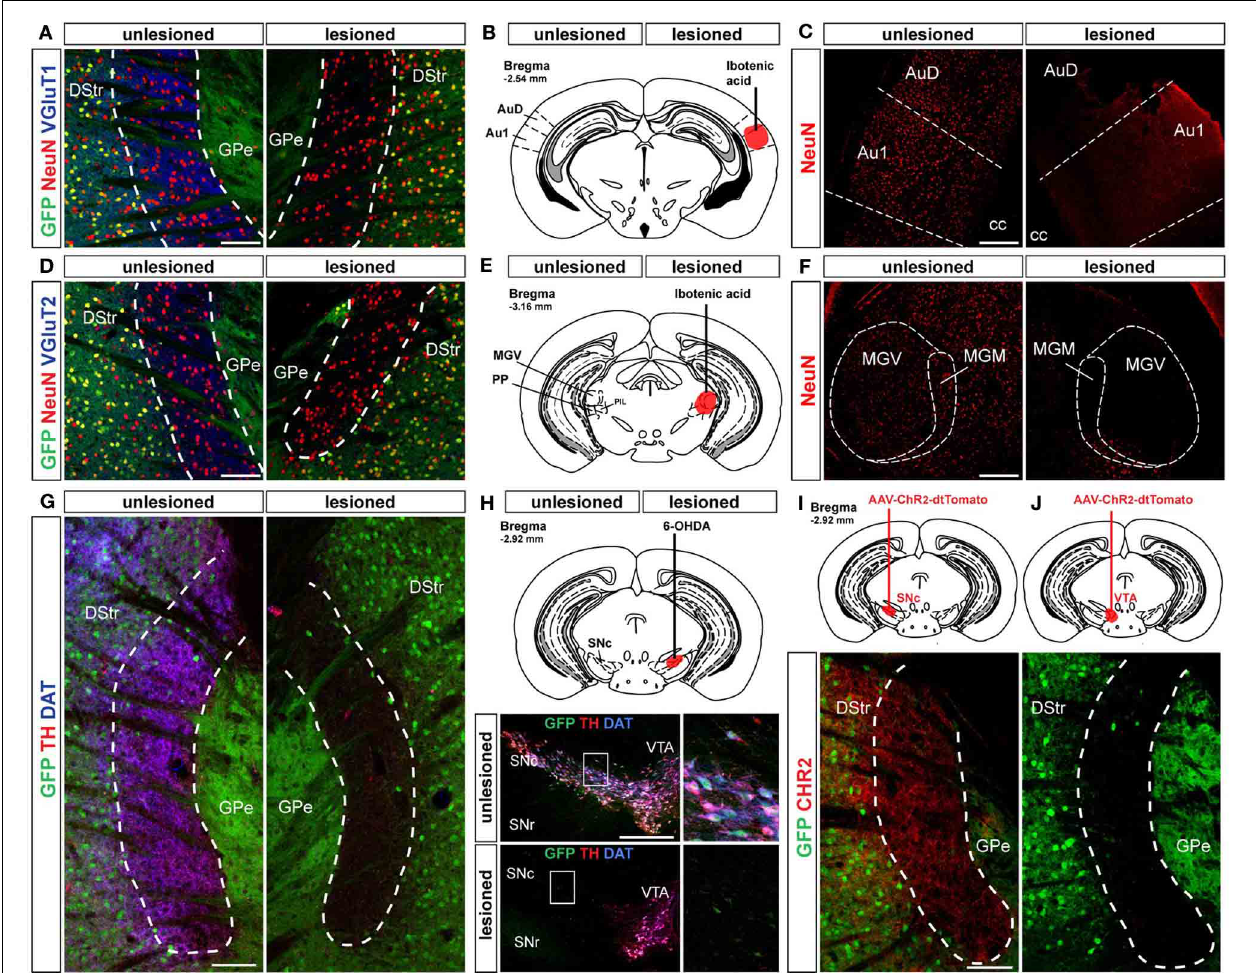
FIGURE 8 | Cortical, thalamic and dopaminergic inputs to the D2R/A2aR-expressing MSNs-poor zone of the caudal striatum. (A) Triple immunostaining GFP (green), NeuN (red) and VGluT1 (blue) allowing the identification of corticostriatal inputs. Scale bar: 100 μ m. (B) Localization of the lesion induced by ibotenic acid microinjection in the primary auditory cortex (bregma, − 2 . 54mm). (C) NeuN (red) immunoreactivity in auditory cortex of Drd2-EGFP -lesionedmice ( n = 3). (D) Triple immunostaining GFP (green), NeuN (red) and VGluT2 (blue) allowing the identification of thalamostriatal inputs. Scale bar: 100 μ m. (E) Localization of the lesion induced by ibotenic acid microinjection in the medial geniculate thalamic nucleus (bregma, − 3 . 08mm). (F) NeuN (red) immunoreactivity in medial geniculate thalamic of Drd2-EGFP -lesionedmice ( n = 3). Note the loss of NeuN positive neurons on the lesioned sides (C,F) . (G) Triple immunostaining